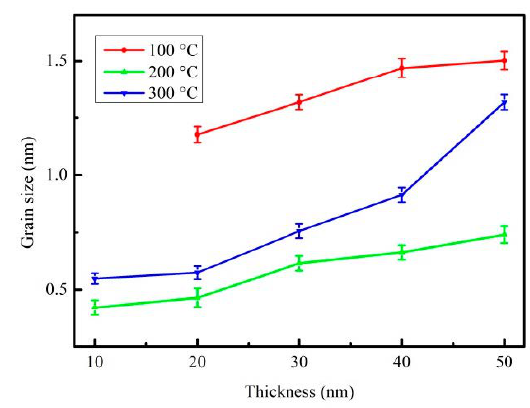
Figure 2. The mean grain size distribution of CoFeBY